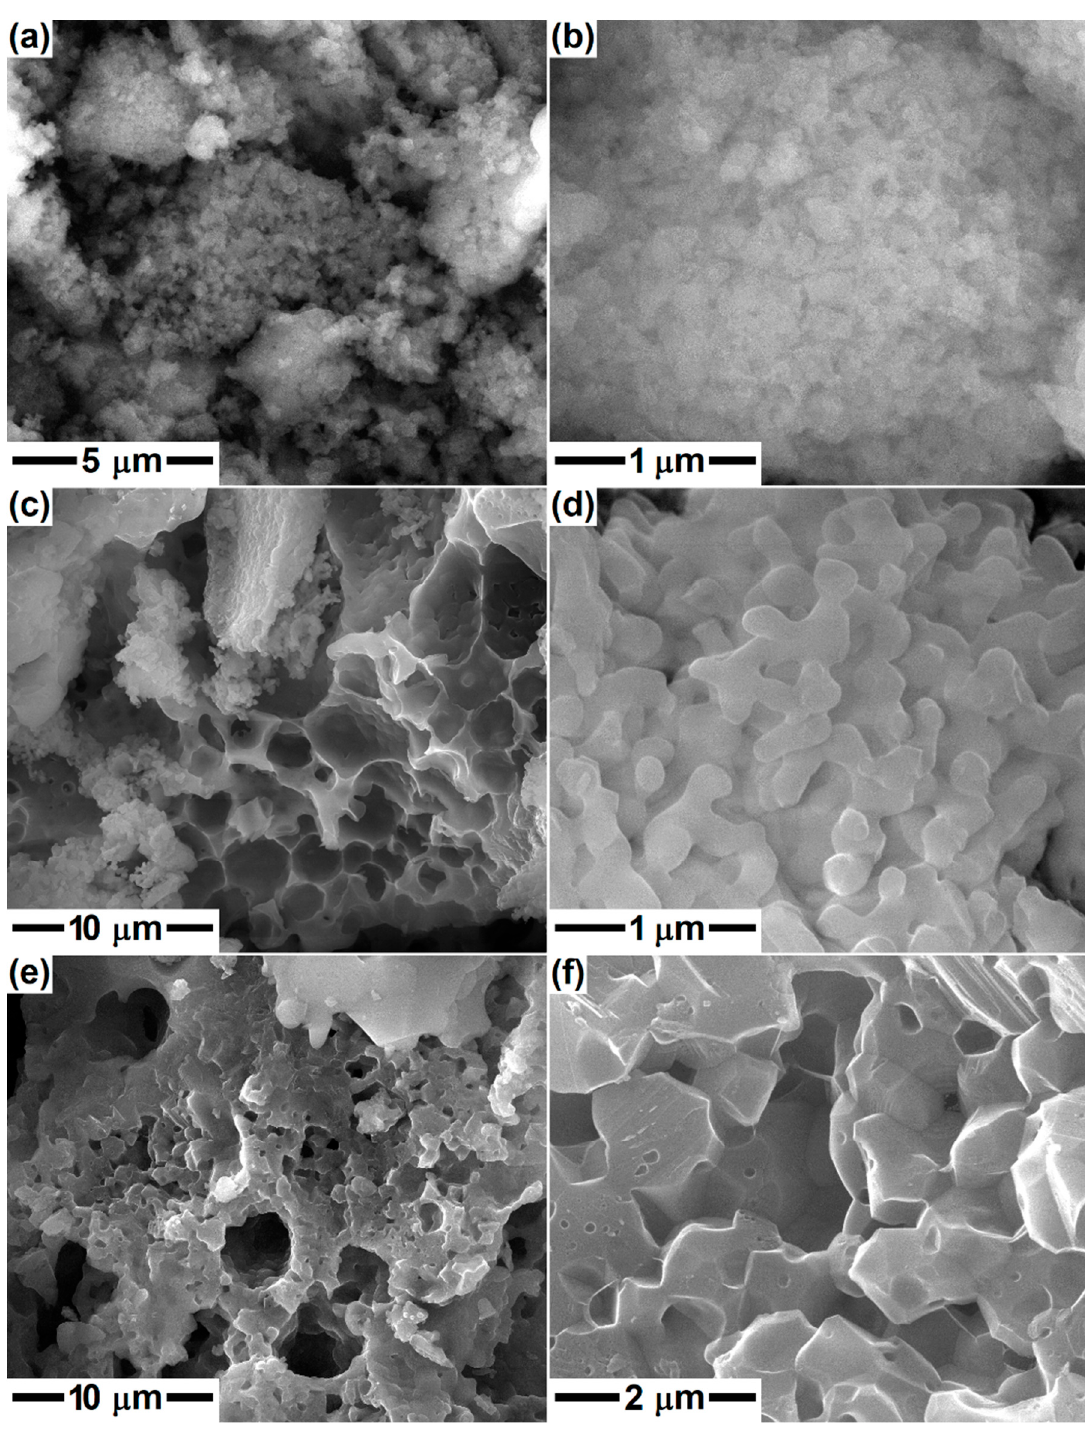
Figure 4. SEM images of the ceramics corresponding to akermanite composition, thermally treated at: ( a , b ) 600 °C; ( c , d ) 1000 °C; and ( e , f ) 1300 °C.